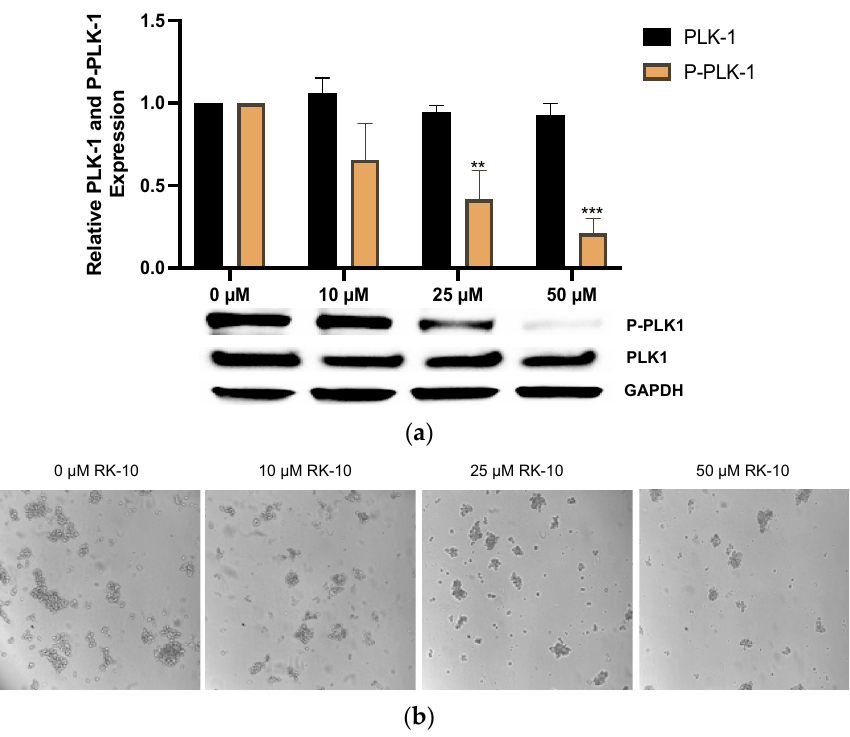
Figure 6. RK-10 inhibits activated PLK1 in MDA-MB 231 mammospheres. ( a ) MDA-MB 231 cells were cultured as mammospheres and treated with 0, 10, 25, and 50 µM of RK-10 for 24 h. Afterwards, the cells were assayed by immunoblotting to examine the expression levels of phosphorylated PLK1 and GAPDH (loading control). ( b ) Representative microscopic images of RK-10-treated MDA-MB 231 mammopsheres. Student’s t -tests were performed, and treatments were compared to the DMSO control. Results are expressed as the means ± SDs (*** p < 0.001, ** p < 0.01), and data are representative, from one of at least three independent experiments.